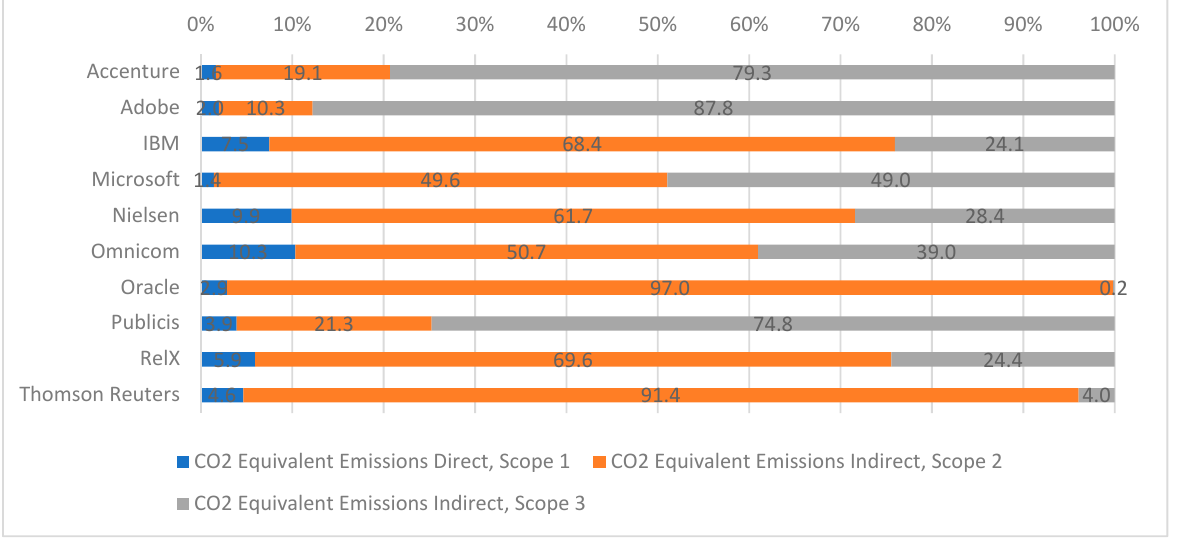
Figure 1. Structure of CO 2 (or equivalent) emissions among Scopes 1–3 in 2020 financial year. Source: Refinitiv database, authors’ calculations.